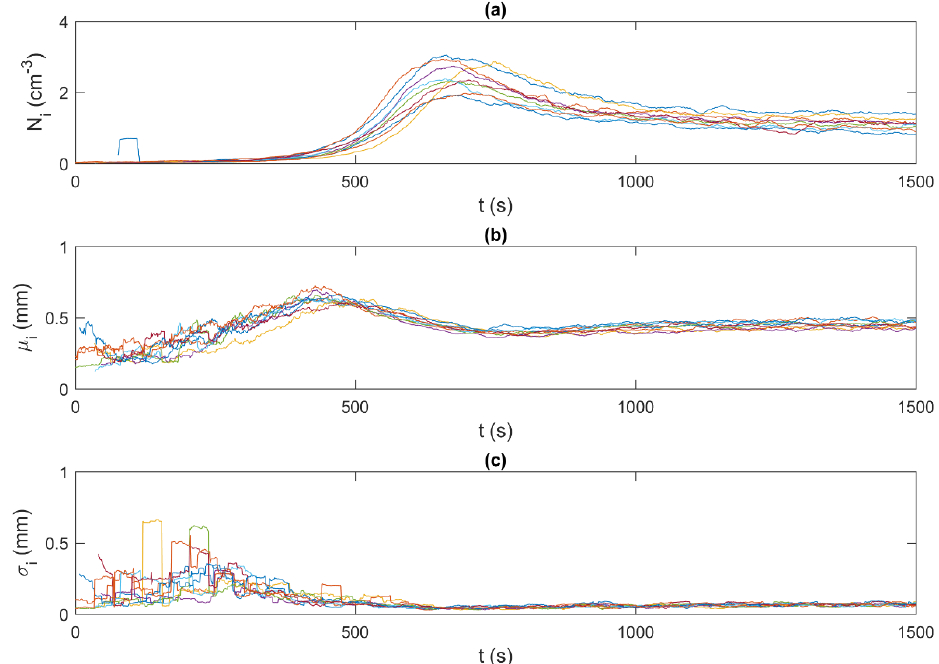
Figure 9. Time series of frazil ice particle properties for all 15‰ experiments (shown in different colours). (a) N i , the number of frazil ice particle per unit volume (cm − 3 ),; (b) µ i , the mean size of frazil ice particles (mm); and (c) σ i , the standard deviation of the size of frazil ice particles (mm). Note that the data were smoothed using a 35s moving average.